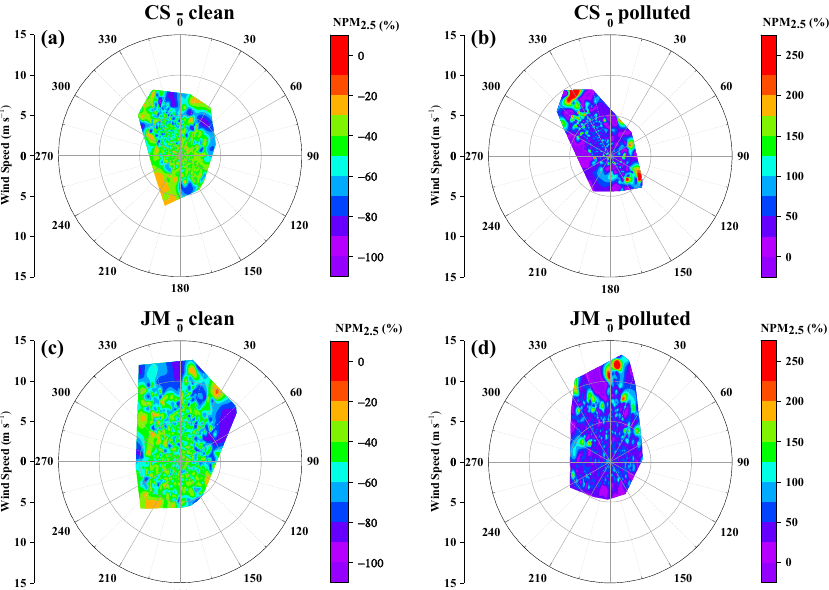
Figure 3. Bivariate polar plots of hourly variations in wind speed (round radius, m s –1 ) and direction (angles, ◦ ) to normalized PM 2.5 concentrations (color contours, µ g m –3 ) in ( a , b ) CS and ( c , d ) JM under clean and polluted conditions for winters from 2016–2020. clean and polluted conditions for winters from 2016–2020.